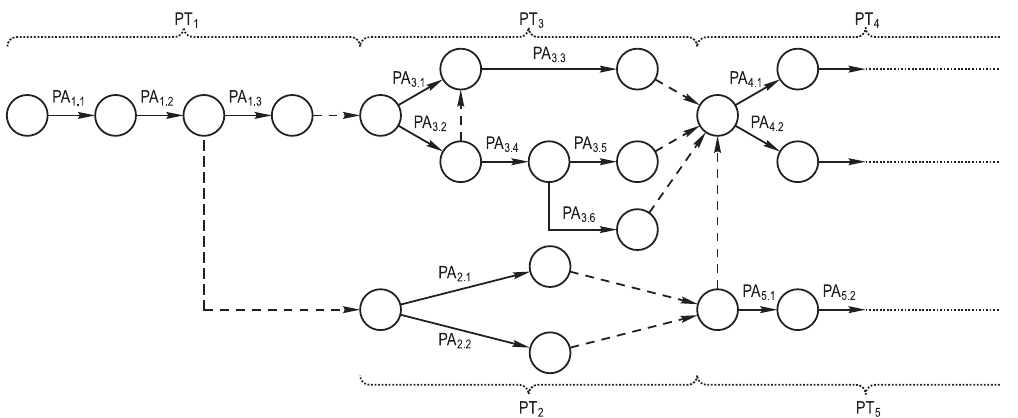
Fig 3. Fragment of TNM of possible actions to implement strategic